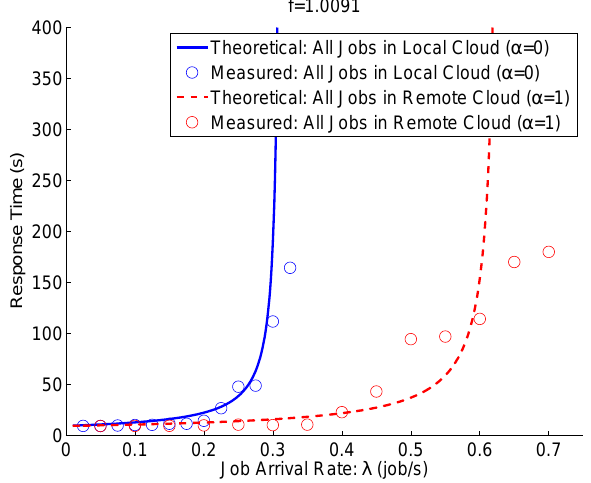
Figure 4. Job response time for the local ( α = 0 ) and remote cluster ( α = 1 ).